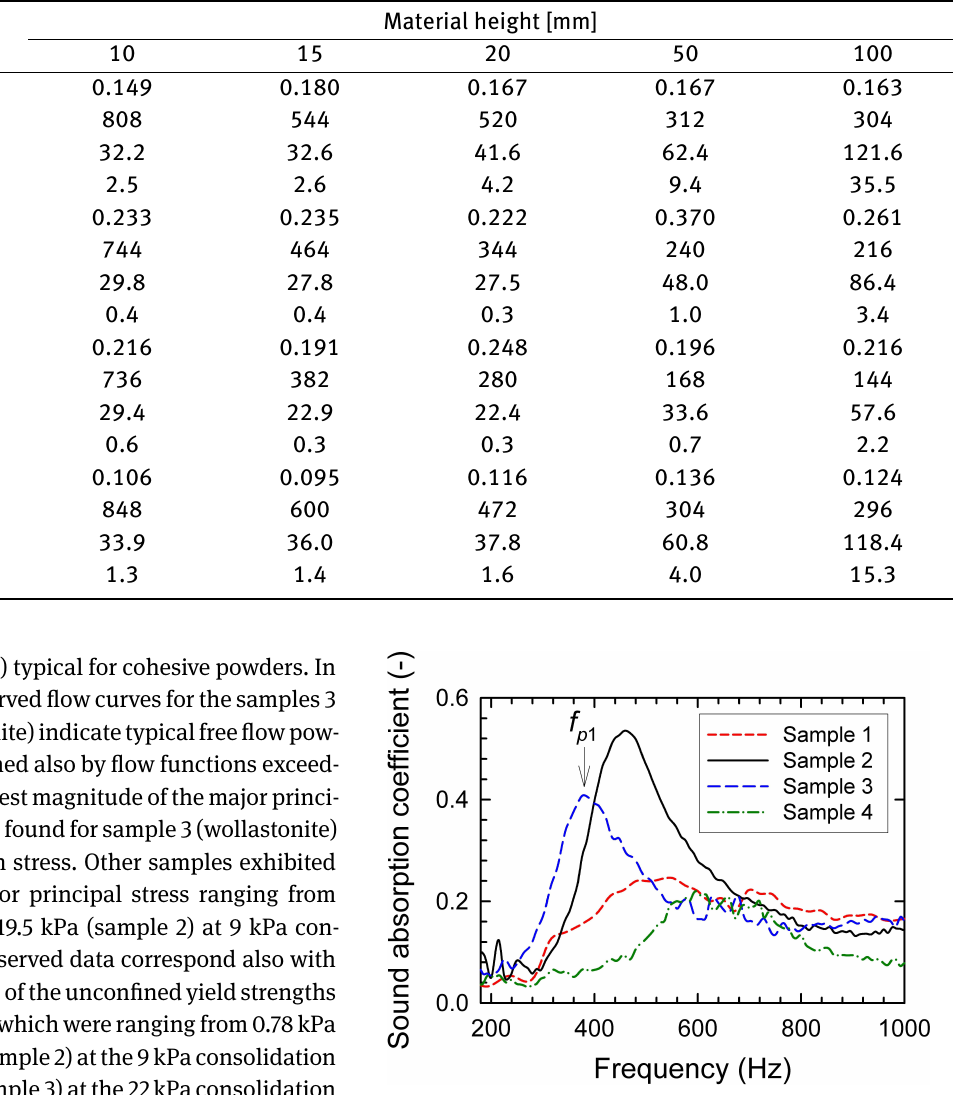
Figure 4: Frequency dependencies of the sound absorption